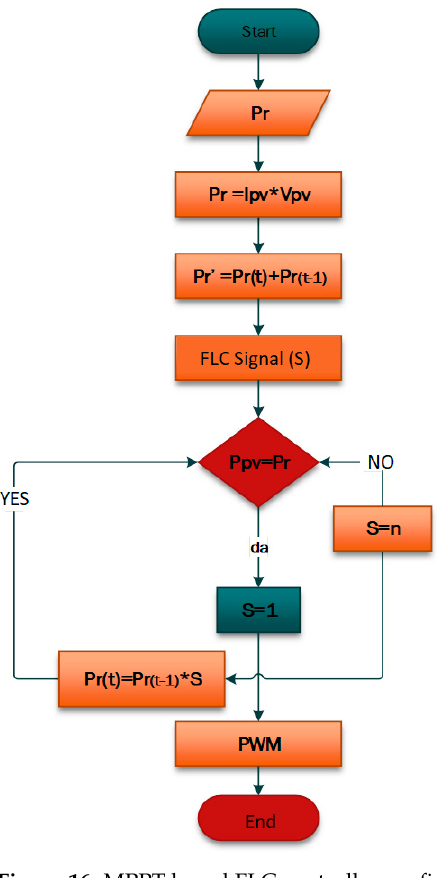
Figure 16. MPPT-based FLC controller configuration.